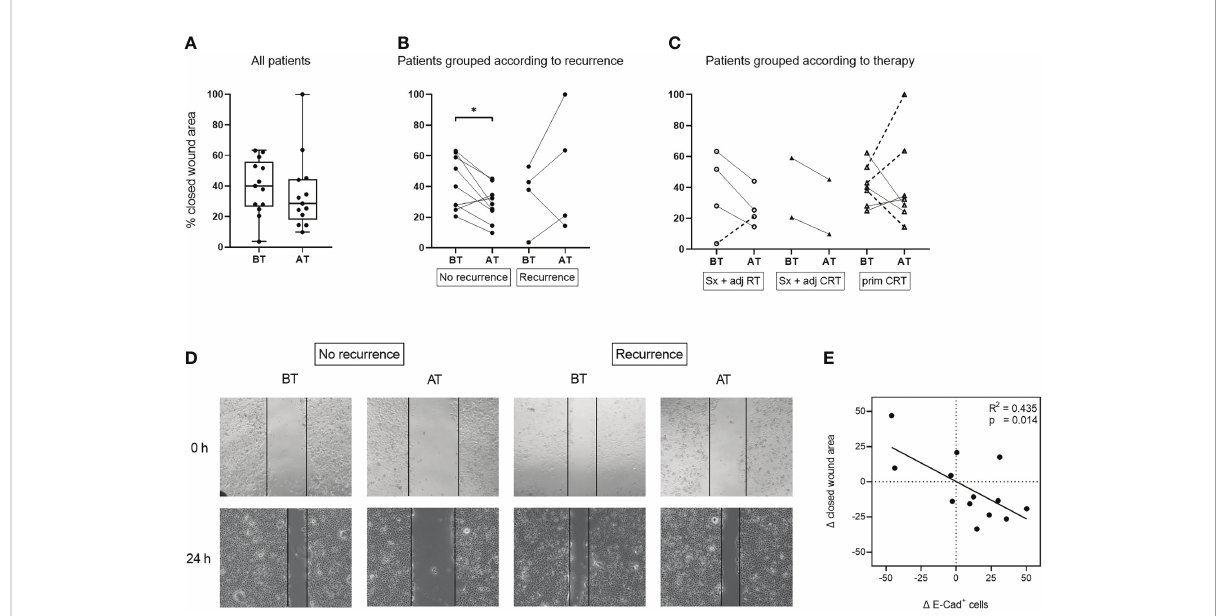
FIGURE 5 Migratory potential of UD-1 cells after co-incubation with exosomes isolated from plasma of HNSCC patients before and after therapy. UD-1 cells were co-incubated with exosomes isolated from plasma of n = 13 HNSCC patients BT and AT. After the fi rst 24 h of co-incubation, cells were injured with a scratch and incubated for another 24 h Results are shown as % of closed wound area. Ungrouped results (A) are plotted as box-and-whisker blots representing the median value, the 25th and 75th quartiles and the range. Results grouped according to recurrence (B) or therapy (C) are plotted as before-after blots. N = 9 HNSCC patients had no recurrence, while n = 4 had a recurrence. N = 4 HNSCC patients were treated with Sx + adj RT, n = 2 with Sx + adj CRT and n = 7 with prim CRT. Wilcoxon related samples tests were applied to compare BT and AT. * corresponds to p ≤ 0.05. (D) Representative images of UD-1 cells (5-fold magni fi cation) co-incubated with exosomes from plasma of a non-recurrent and a recurrent HNSCC patient before and after therapy at 0 h and 24 h after the scratch. (E) Pearson correlation analysis of n = 13 HNSCC patients between the exosome induced change of E-cadherin protein expression ( D E-Cad + cells) and migratory potential ( D closed wound area) of UD-1 cells, calculated as the difference between BT and AT (expression AT - expression BT ; closed wound area AT – closed wound area BT